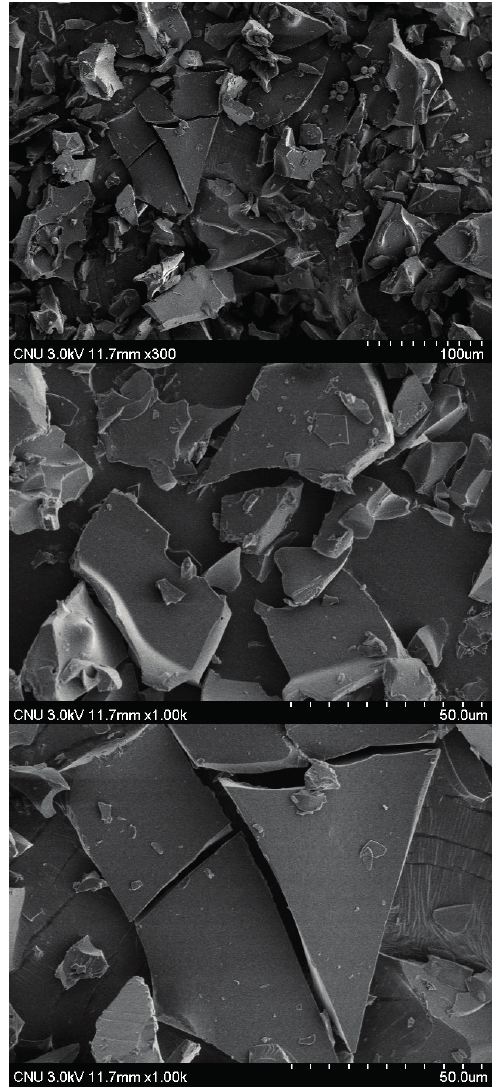
Figure 8. Surface morphology of bee